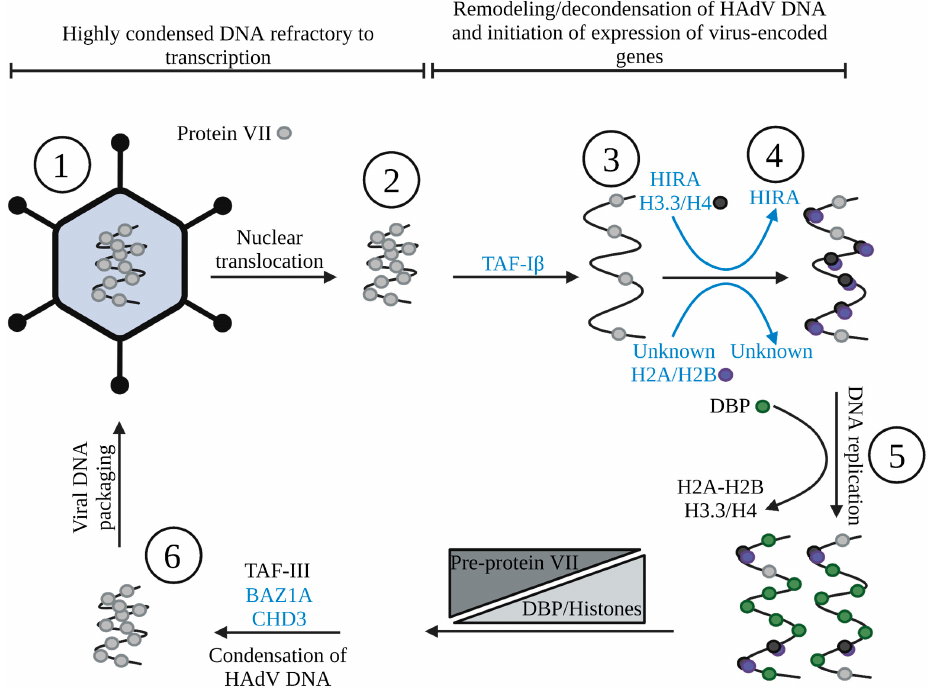
Figure 2. The structure of HAdV DNA throughout the replicative cycle. Black represents events/processes we know, while blue represents speculation based on the literature. Within the viral capsid, condensed viral DNA is wrapped in protein VII [50] (1). After entry into the cell, the protein-VII- wrapped DNA is translocated into the nucleus [77–82] (2) and is subsequently remodeled, possibly involving TAF-I β [87] , removing some protein VII from viral DNA and decondensing the genome (3). Cellular histones are deposited onto viral DNA [89,95,96,112] , possibly by HIRA [95] and other histone chaperones (4), allowing for more efficient early gene expression. The nucleosome-like structures present on the viral DNA contain H2A-H2B, H3.3, and H4 [89,96] . Following DNA rep- lication, the viral DBP is deposited onto replicating genomes [134,135] , while some histones are present for late gene expression [96] , possibly on two distinct DNA populations (5). As late infection progresses, histone pools decrease and are gradually replaced on viral DNA by pre-protein VII by TAF-III [145] , recondensing the genome (6). The condensed viral core is subsequently encapsidated [147] and the virion released following lysis of the cell (1). Created with BioRender.com. Author Contributions: Conceptualization, M.R.J.; literature search, M.R.J., R.J.P.; resources, R.J.P.; writing—original draft, M.R.J., R.J.P.; writing—review and editing, R.J.P., M.R.J.; supervision, R.J.P.; funding acquisition, R.J.P.; project administration, R.J.P. All authors have read and agreed to the published version of the manuscript. Funding: Research in the Parks lab is supported by grants to R.J.P from the Canadian Institutes of Health Research (MOP-142316, PJT-178120) and the Natural Sciences and Engineering Research Council (RGPIN-2019-04786). M.R.J is supported by a Queen Elizabeth II Graduate Scholarship in Science and Technology from the Ontario Provincial Government (Canada). Institutional Review Board Statement: Not applicable.